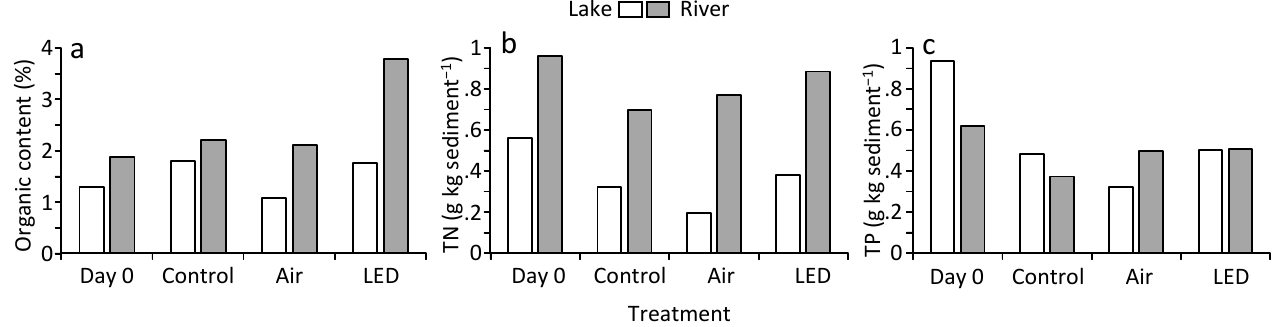
Figure A1. Sediment quality (( a ): organic content, ( b ): TN, ( c ): TP) at the beginning and end of the experiment.